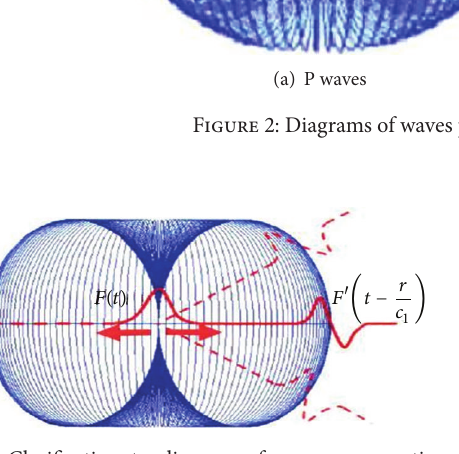
Figure 3: Clarification to diagram of waves propagation from combination of two forces without